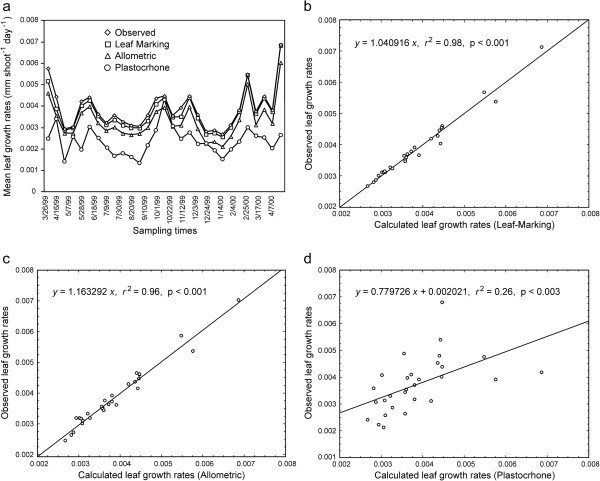
Comparison of observed and calculated leaf growth rates.